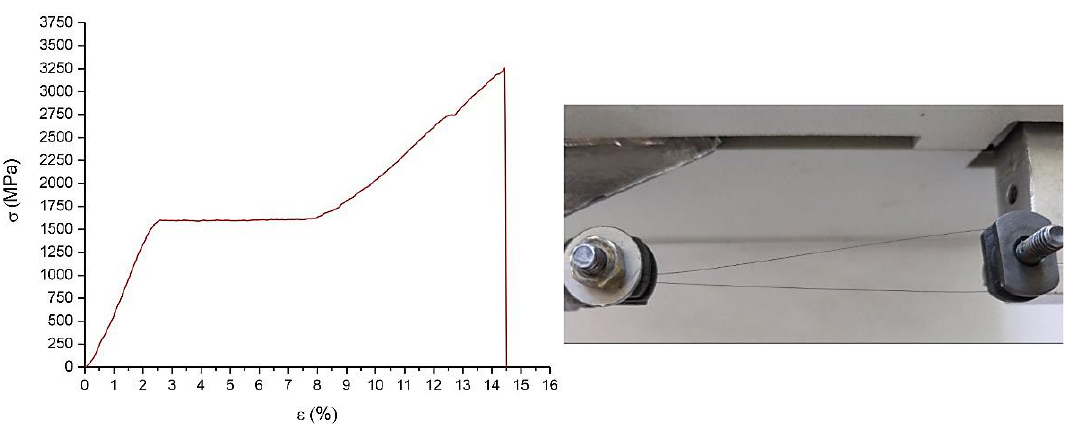
Figure 9. Deformation behavior of a 60 µm diameter TiNi wire with loop geometry.